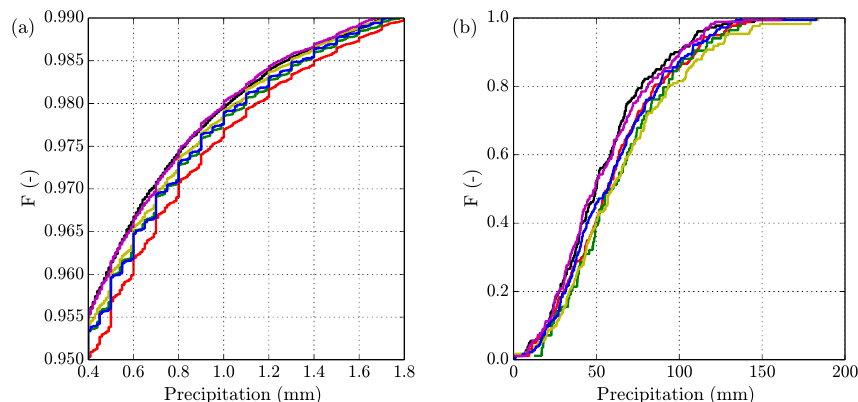
Figure 4. The EDFs of the hourly (a) and monthly (b) precipitation amounts for the gauge at Stuttgart/Schnarrenberg and its five closest gauges for a quantile interval. This shows that the order of the EDFs is quite persistent over a wide quantile range for low and high resolutions. Note: As the daily and hourly data sets are not the same, the colors in the two graphs do not correspond to the same gauges.